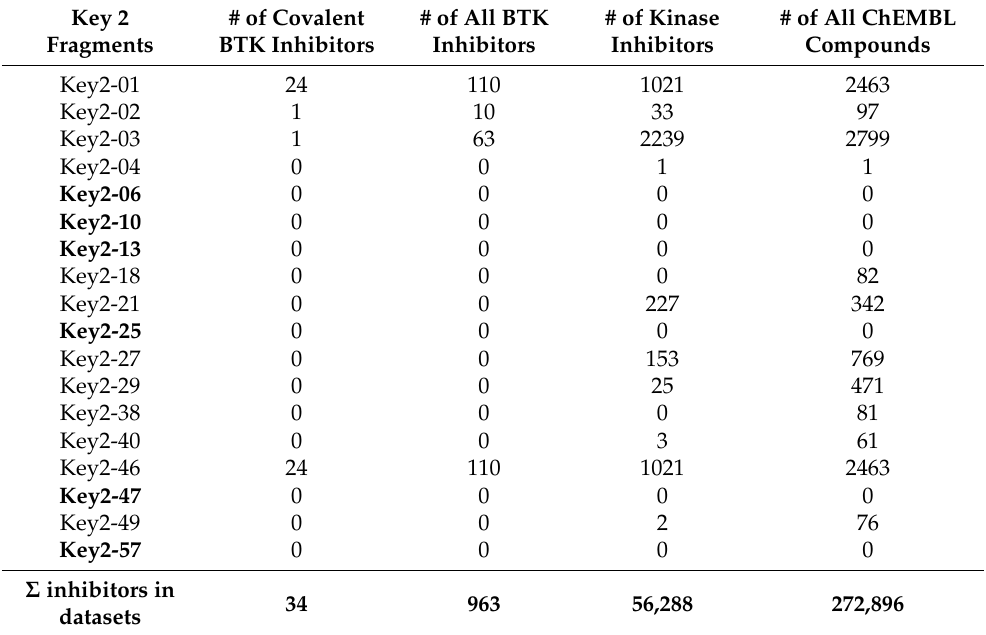
Table 2. Reported are the numbers of cyclic Key 2 substructures from newly designed BTK inhibitors detected in different sets of ChEMBL compounds with high-confidence activity data. Key 2 fragments not detected in any ChEMBL compounds are shown in bold. # stands for